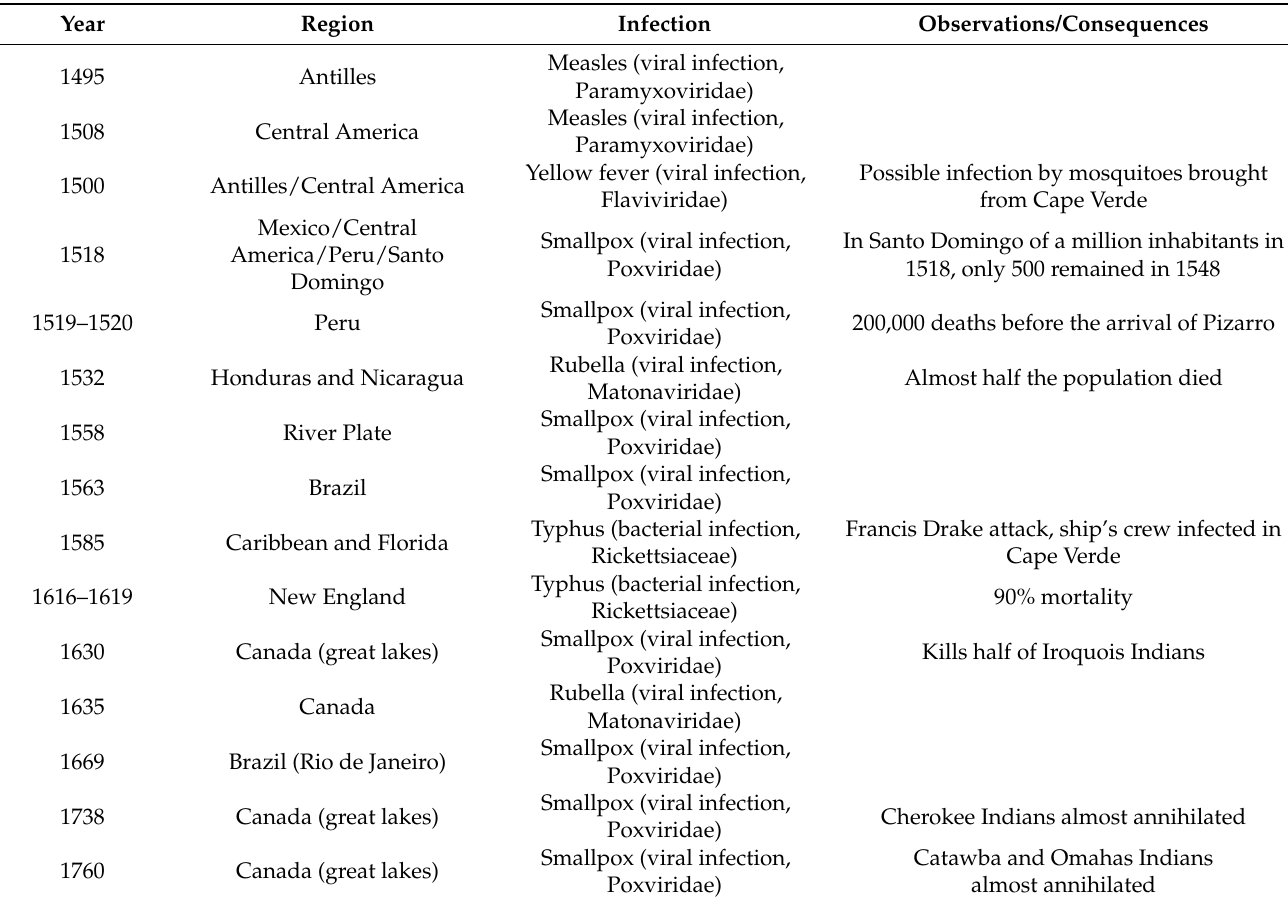
Table 1. Epidemics brought to America by European colonizers from 15th to 18th century